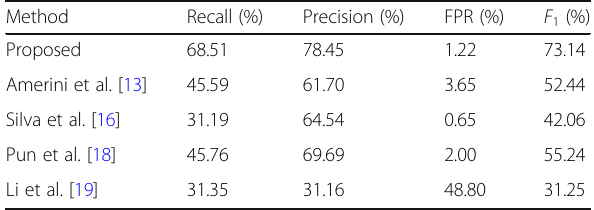
Table 9 Detected results for JPEG